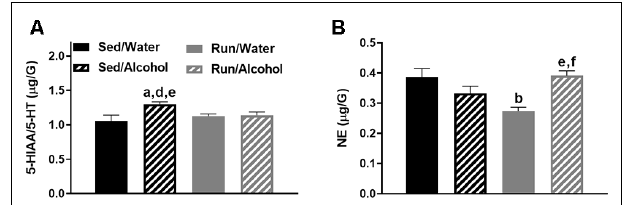
FIGURE 8 | Neurochemical levels in the mouse hippocampus area immediately following the final DID session. The ratio of 5-HIAA/5-HT (A) , and NE concentrations (B) . Data represent means +SEM. a P < 0.05 Sed/Water from Sed/Alcohol, b P < 0.05 Sed/Water from